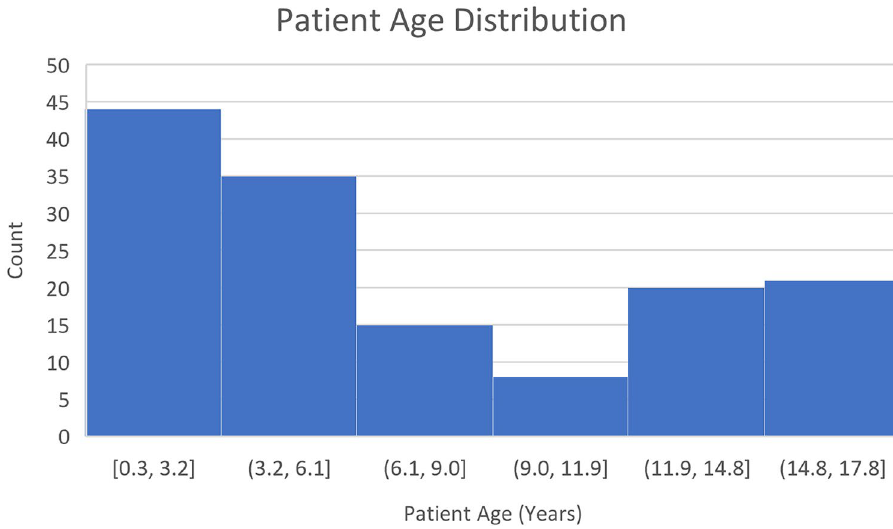
Figure 2. Patient age distribution.